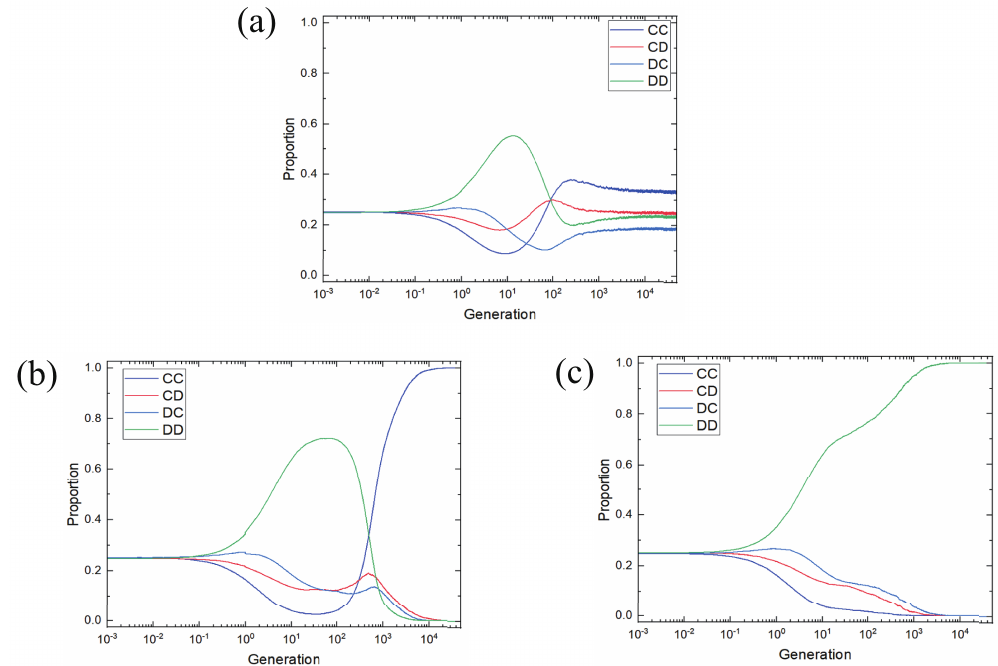
Figure 4. Time evolution of different types of relationships between networks at β = 0.5. From subgraphs ( a – c ), the threshold of influence τ is set to be 0, 8, and 40, respectively. It should be noted that, due to the fact that the results obtained on both networks are qualitatively consistent, only the results obtained on the bottom network are shown here. Other parameters are exactly the same as those in Figure